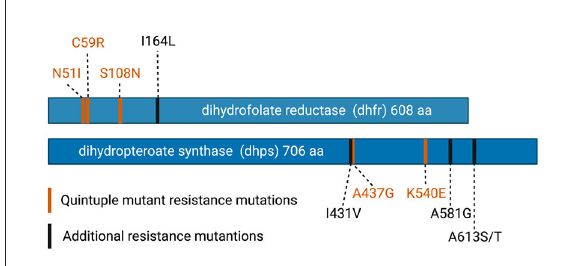
FIGURE1 Mutations in dihydrofolate reductase (dhfr) and dihydropteroate synthase (dhps) that confer resistance to sulfadoxine pyrimethamine. Mutations found in the highly resistant “quintuple mutant” are shown in orange. Additional mutations, that are increasing in prevalence in Africa, are shown in black. Figures generated in Biorender.